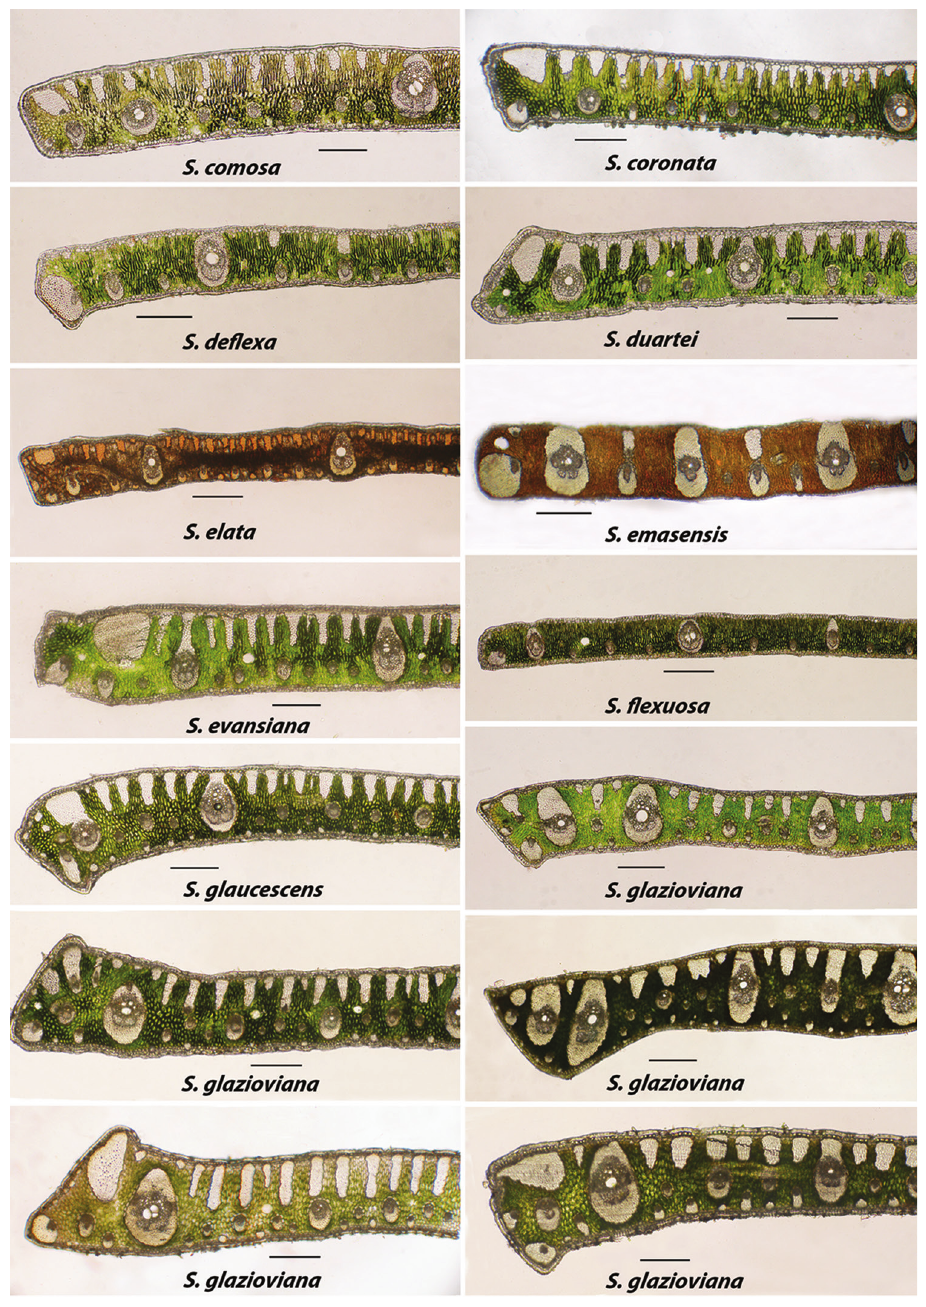
Figure 4. Alphabetically arranged marginal leaflet transections. Syagrus comosa to S. glazioviana . Note variation in S. glazioviana . Bar scale = 0.25